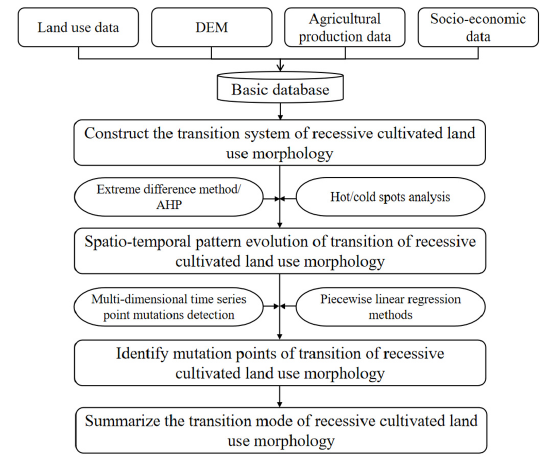
Figure 2. Flow chart of the research process and method.